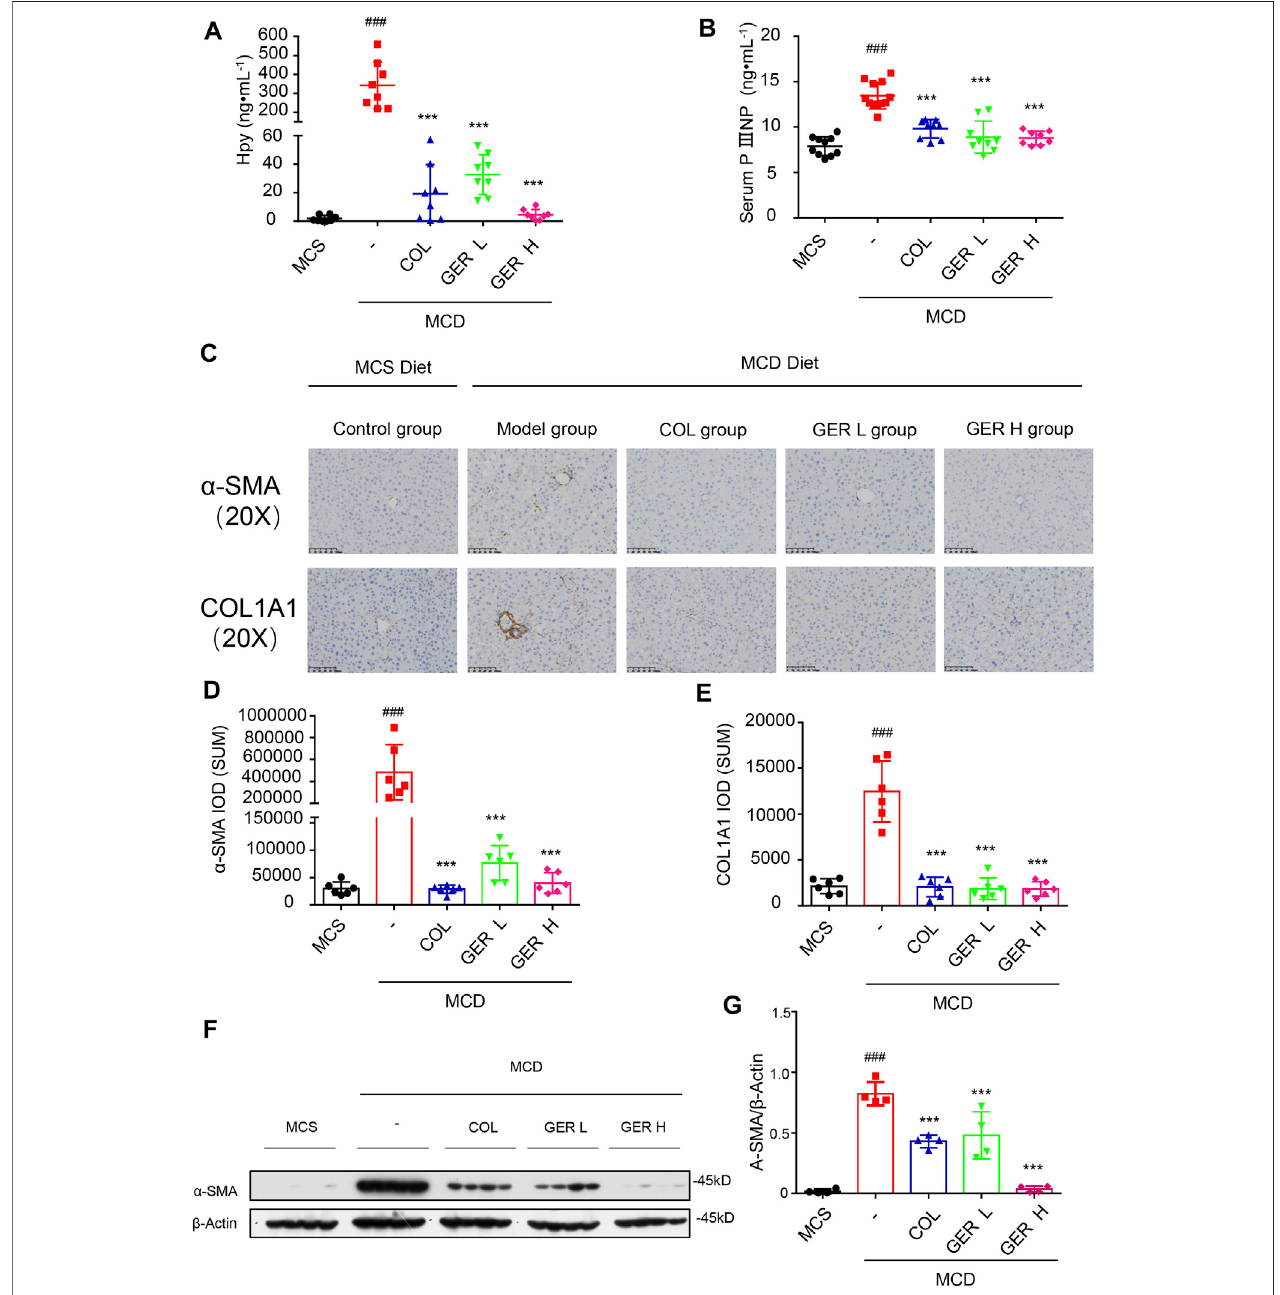
FIGURE 6 | GER inhibits the activation of HSCs via TGF- β /Smad signaling pathway in MCD diet-induced liver fi brosis model. (A) The content of hydroxyproline in liver tissue ( n (cid:2) 8). (B) The serum content of P Ⅲ NP ( n (cid:2) 8 − 11). (C) Immunohistochemistry for α -SMA and COL1A1 in liver sections (scale bars, 100 μ m). (D – E) Quanti fi cationof α -SMAandCOL1A1expressionindifferenttreatmentgroups( n (cid:2) 6). (F) Westernblotfor α -SMAandSmad3proteinlevelsinlivertissue,and β -actinwas used as the loading control ( n (cid:2) 4). (G) Quantitative analysis of α -SMA and β -actin expression ( n (cid:2) 4). All data are presented as means ± SEM. ### p < 0.001 vs. the MCS group. *p < 0.05, *** p < 0.001 vs. the model group.